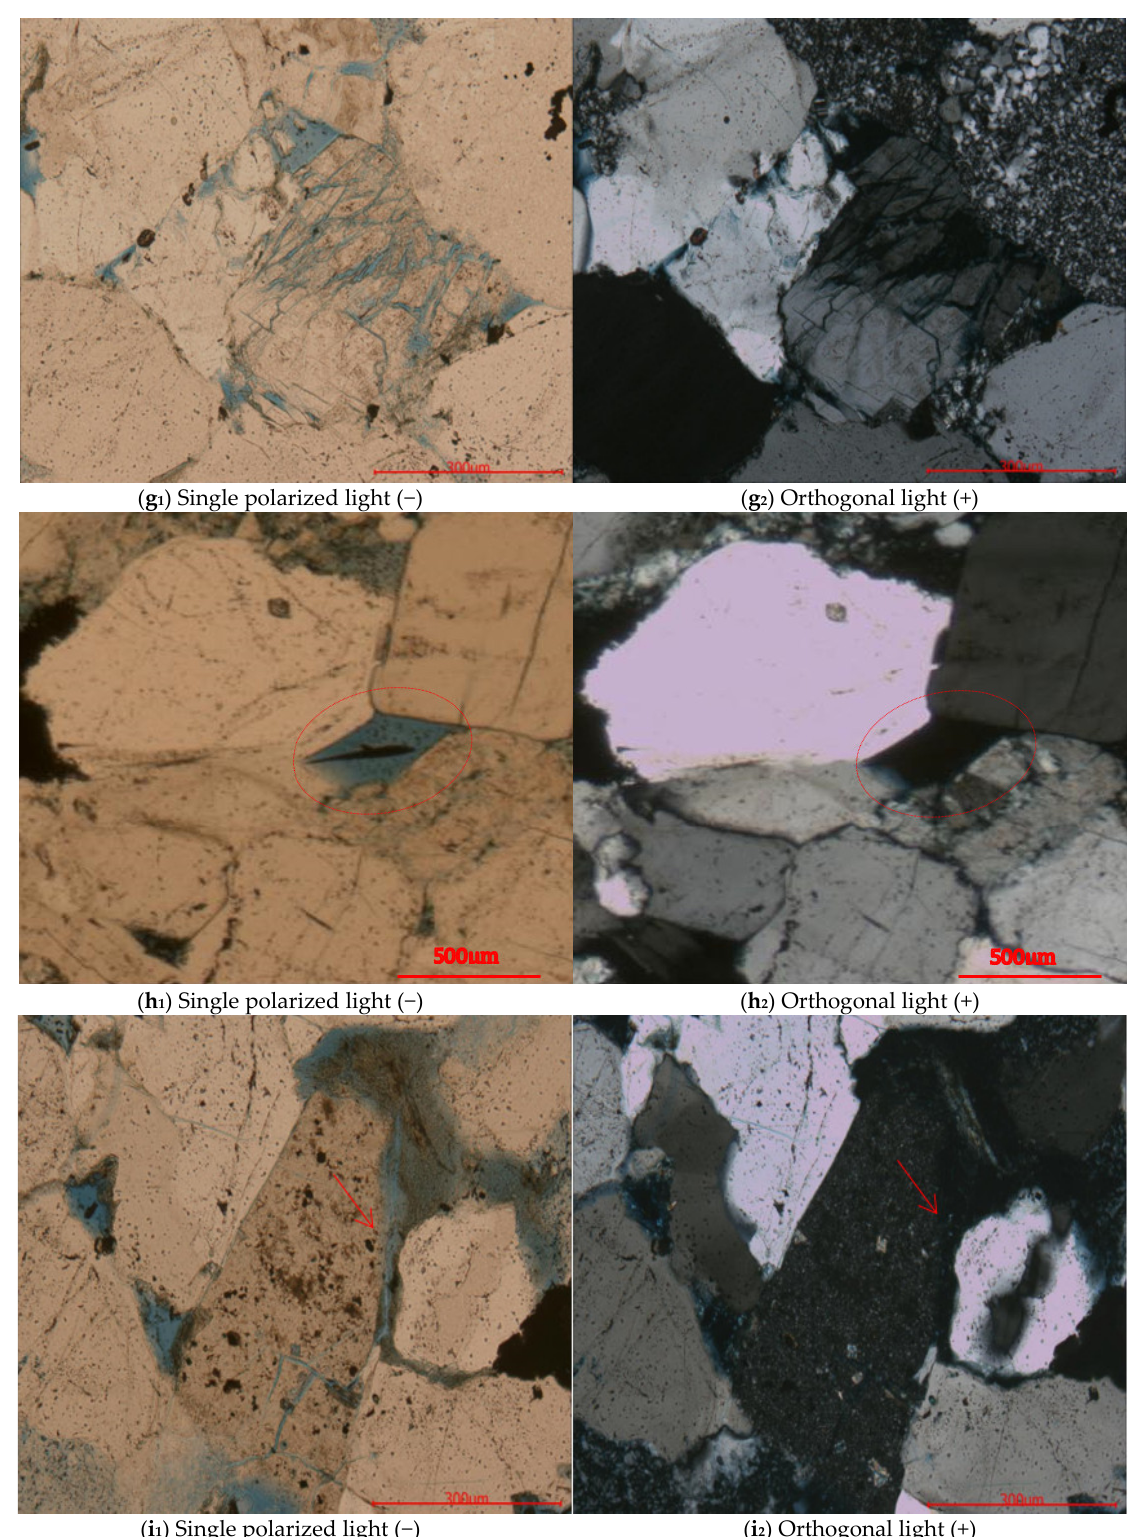
Figure 1. Pore type diagram.